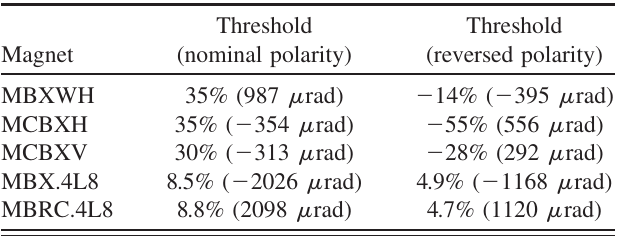
TABLE I. The required thresholds of the magnets to avoid beam accident scenarios on injection, rounded to a integer percentile, for beam